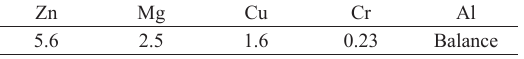
Table 1. Nominal chemical composition of the AA7075-T651 alloy (%).